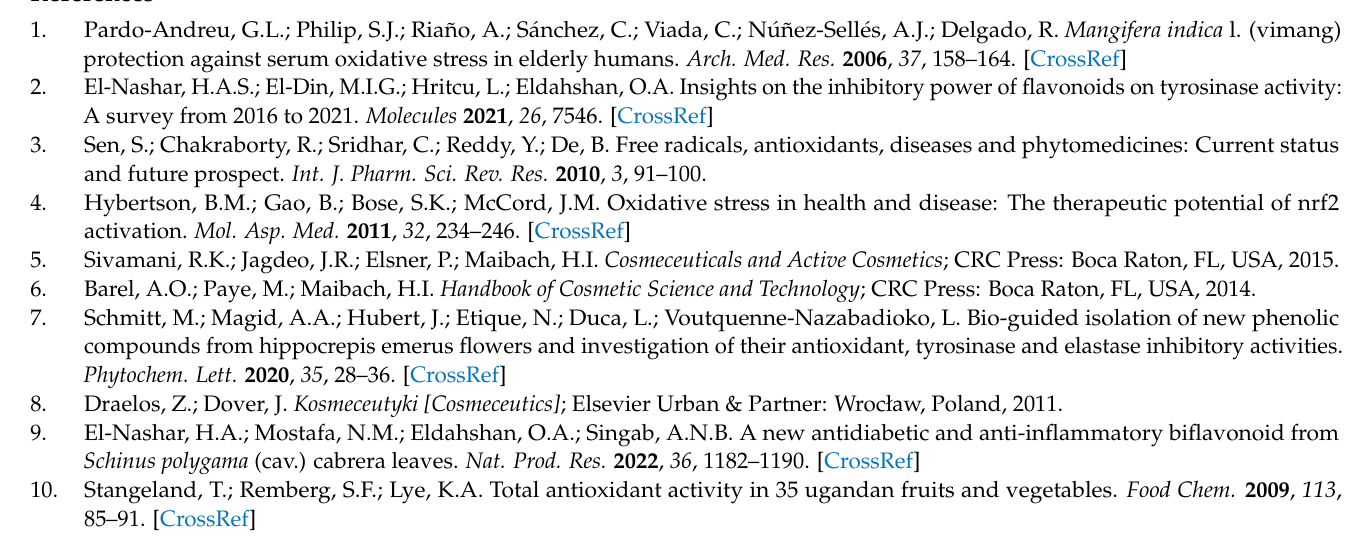
(full spectrum), Figure S2: 1 H-NMR spectrum of compound (aromatic region), Figure S3: APT spectrum of compound (full spectrum), Figure S4: HMBC spectrum of compound, Figure S5: HSQC spectrum of compound, Figure S6: 1 H, 1 H-COSY spectrum of compound, Figure S7: (-)ESI-MS of